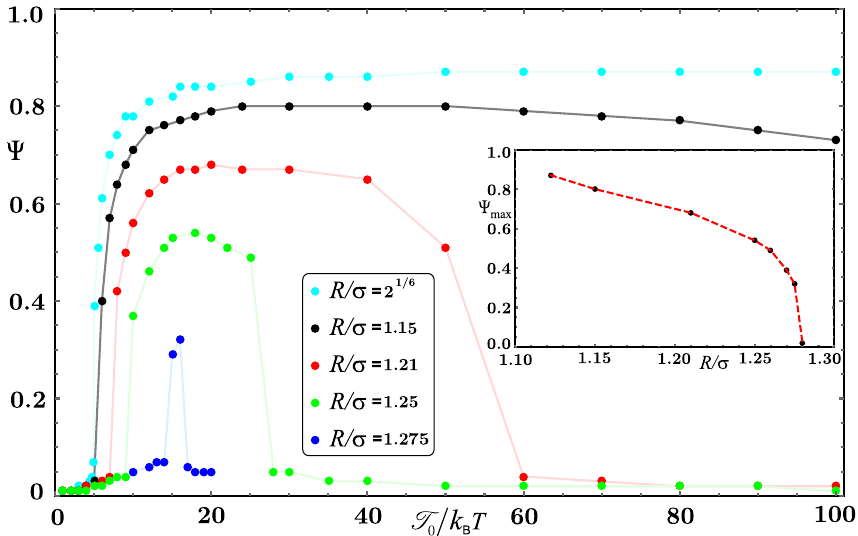
Figure 4. The polar order parameter (cid:31) as a function of non-reciprocal interaction amplitude T 0 for selected values of interaction range R . The inset shows the maximum of the order parameter, (cid:31) max , versus R . The measured values are shown in (colored) circles. Continuous and dashed lines are guides to the eye.